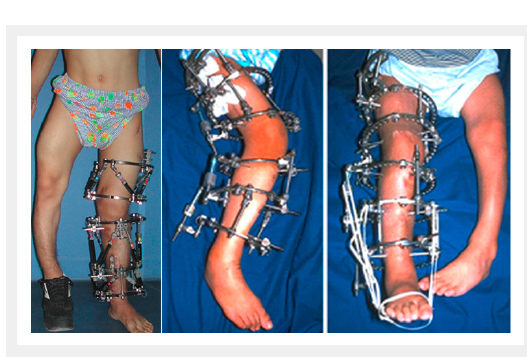
Standing photos of three patients of different ages who presented with windswept deformity (the appearance of an abnormal valgus deformity in one knee in association with varus in the other). Clinically, the average valgus deformity was 35° and the average varus deformity was 22°.